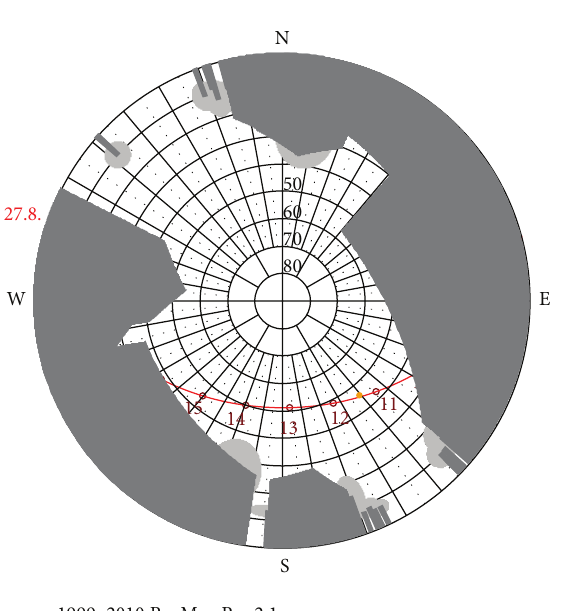
Figure 11: Polar diagram for the sky view factor (zone 2) in Birobidzhan.